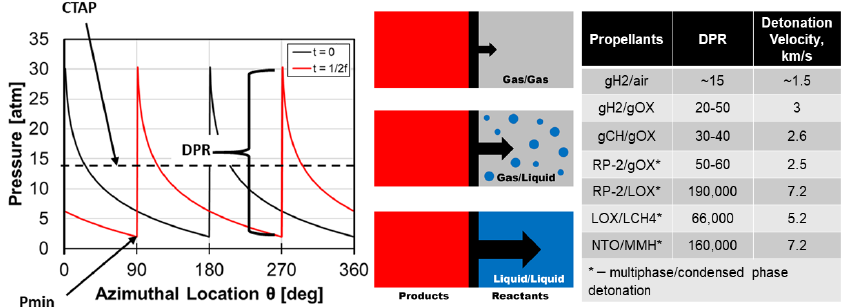
Figure 2. Detonation pressure ratios (DPR) and detonation velocity for numerous propellant combinations involving gaseous and liquid reactants .